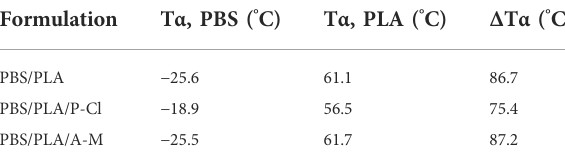
TABLE 3 Dynamic mechanical analysis of PBS/PLA blends with and without ionic liquids (1